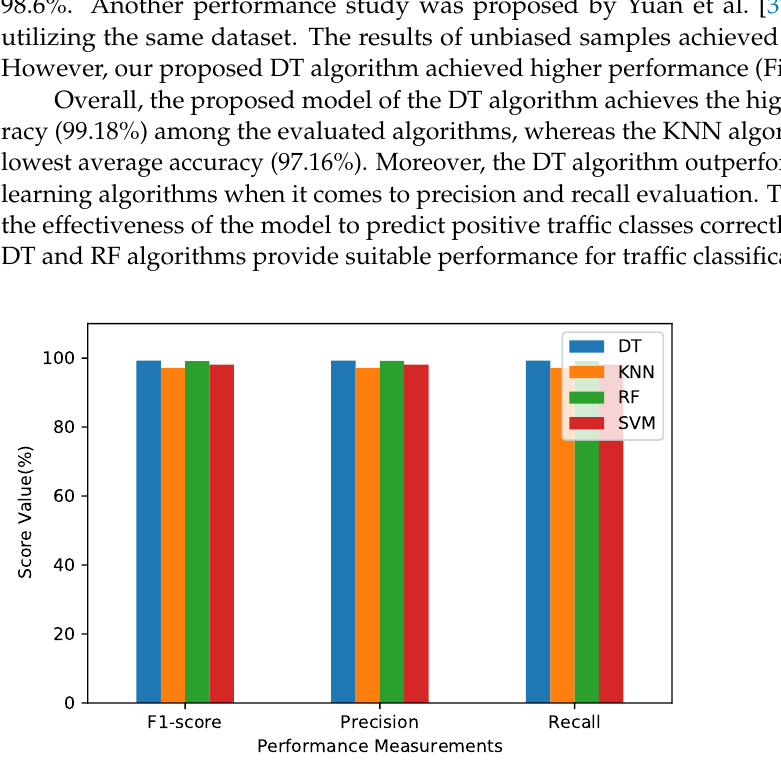
Figure 6. F1-score, precision, and recall performance measurements of machine learning algorithms.